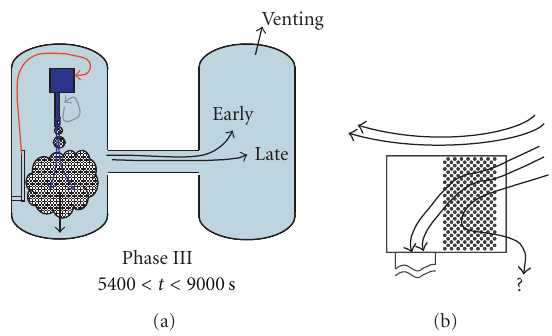
Figure 27: Suggested flow pattern for 0 < t < 3600 s.